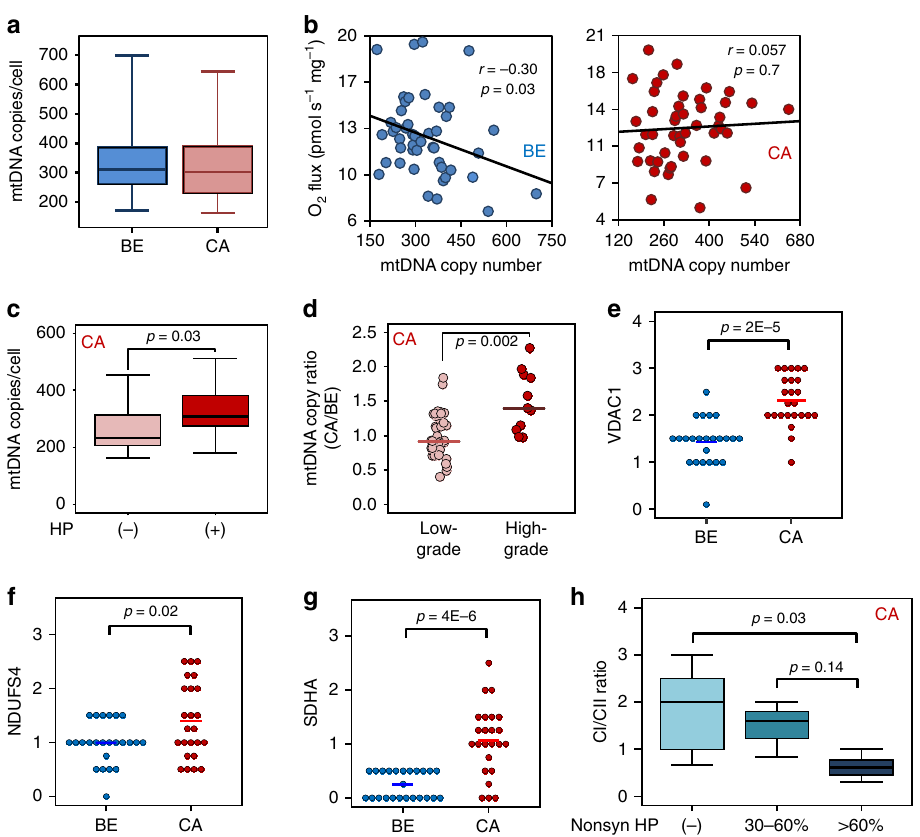
Fig. 6 mtDNA copy number and mt-mass load. a Boxplot of mt-CN per cell in the benign (blue, N = 50) and malignant (red, N = 50) tissue samples. Data are presented as boxplots indicating median, 25th – 75th percent percentile (box) and minimum and maximum values (whiskers). b Correlation of maximal NS-ET capacity (NS E , y -axis) and mt-CN ( x -axis) in benign (BE, blue circles, N = 50) and malignant tissue (CA, red circles, N = 50). Linear correlation was established using Pearson ’ s correlation coef fi cient (r) while correlation was tested for signi fi cance using two-tailed t -test. c Mean mt-CNs ± SD